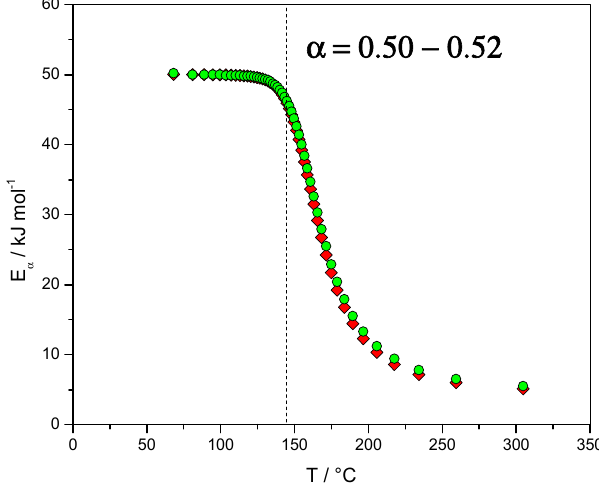
Figure 14. Non-isothermal data. Dependence of the effective activation energy ( E α ) with temperature ( T ). Red lozenges: E α computed with FR method, green circles: E α computed with NLN method. Application of the compensation parameters method [11] in the interval 0.05 < α <